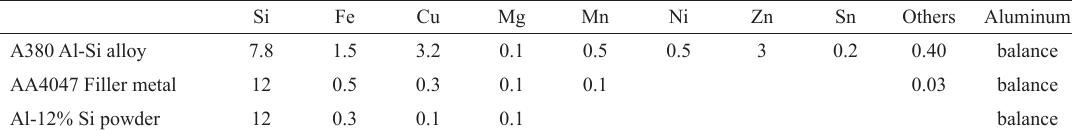
Table 1: Composition of the used alloys (all values are percentage by weight).